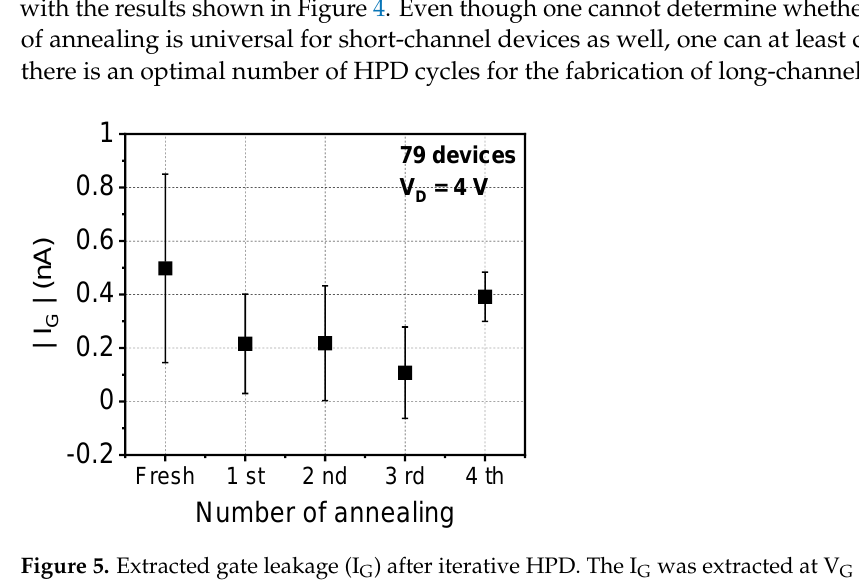
G ) after iterative HPD. The I G was extracted at V G =